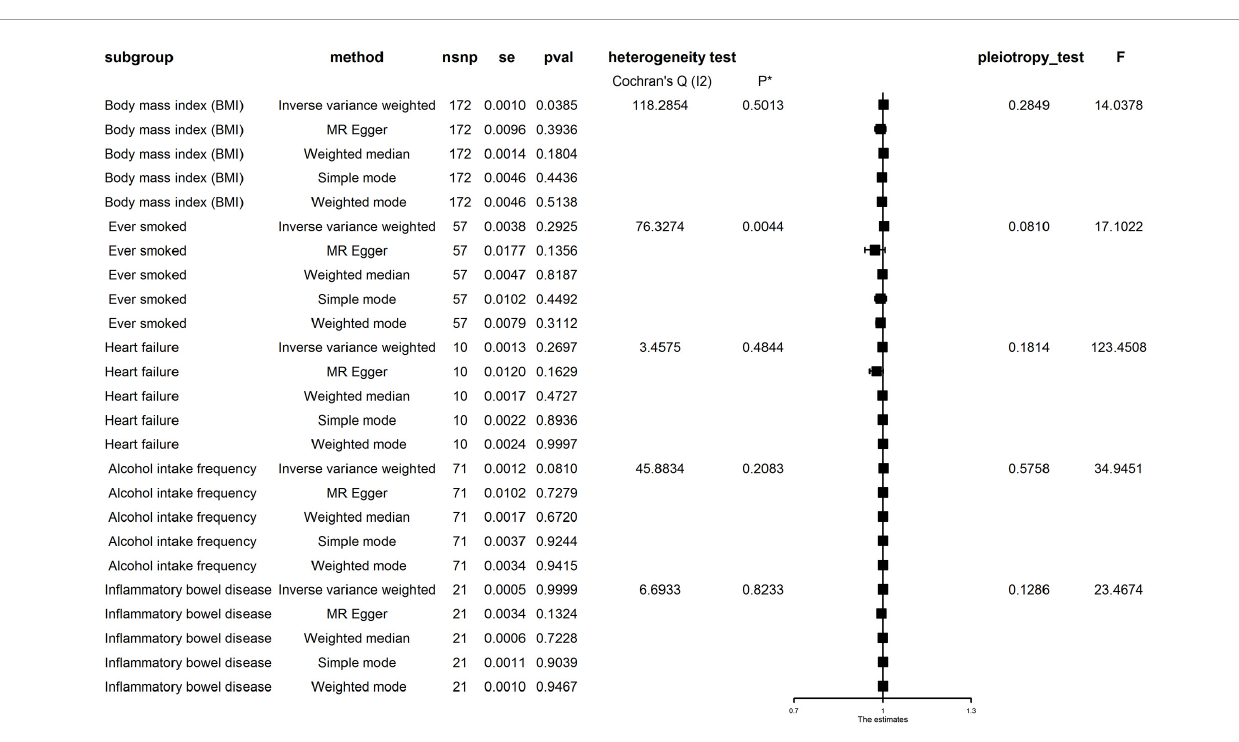
FIGURE6 Mendelian randomization (MR) analysis for the causality of body mass index (BMI), ever smoking, heart failure, alcohol intake frequency, and inflammatory bowel disease (IBD) with the risk of pulmonary embolism (PE). MR, Mendelian randomization; IVW, inverse variance weighted; OR, odds ratio; CI, confidence interval; WM, weighted